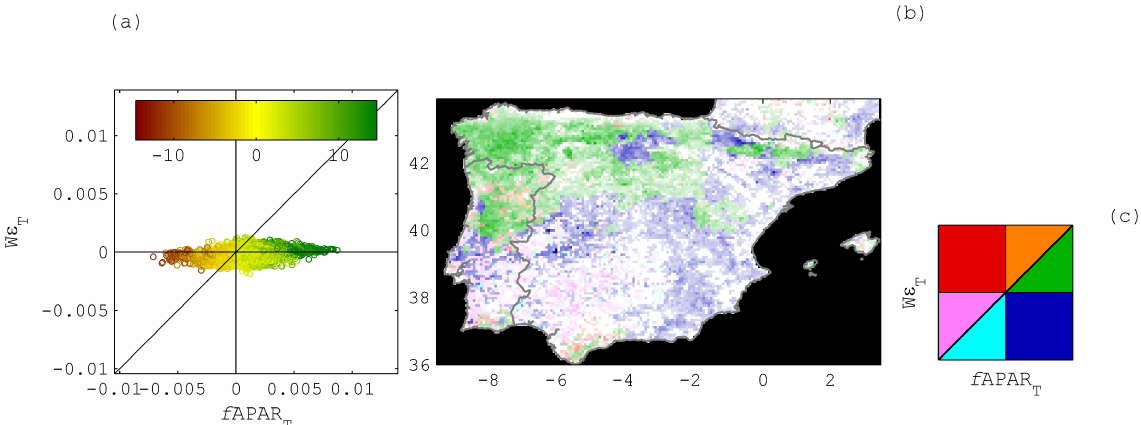
Fig. 11. Decomposition of NPP D trends (gCm − 2 yr − 2 ) into W ε and f APAR trends, W ε square meter per year) (a) . The spatial distribution of W ε NPP D according to its position in (a) following the diagram in (c) . The colour intensity in (b) is proportional to the magnitude of NPP D T